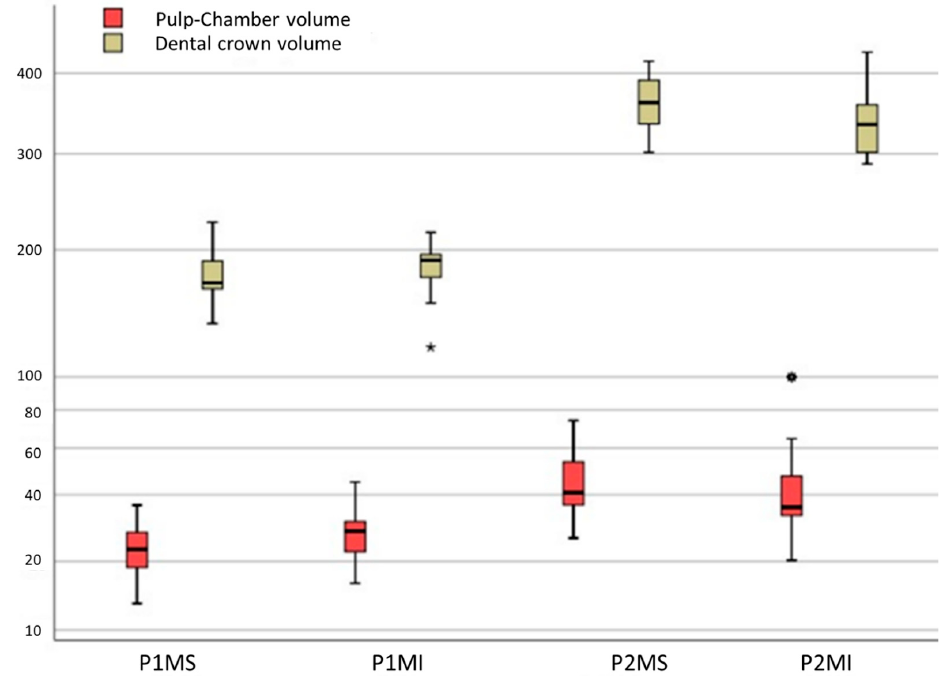
Figure 9. Box plot of pulp chamber (PV) and dental crown volume (CV). Outlier data in 1MI box of CV ( * ) ; outlier data in P2MI box of PV ( * ).